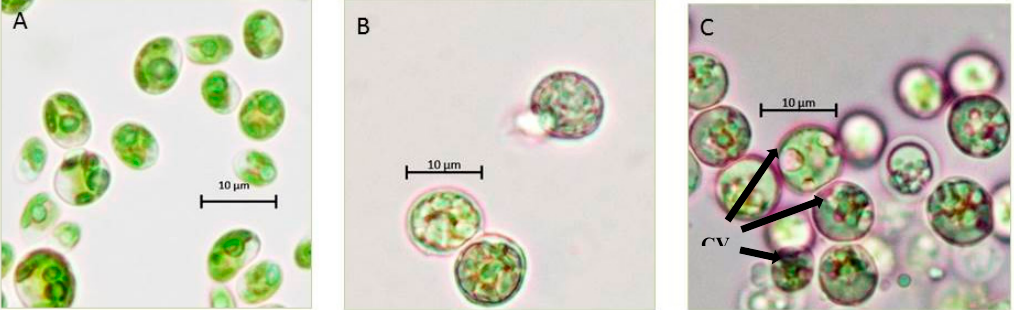
Figure 4. Morphological characterization of the Chlorella sp. QUCCCM3. Strains were cultivated under ( A ) control condition; ( B ) 40 °C; and ( C ) continuous light at 100× magnification, using light microscopy (Primo star HAL microscope, full Kohler, Carl Zeiss, Germany); CV: carotenoids vesicle. The cells cultivated under both stresses showed a spherical shape instead of the normal oval